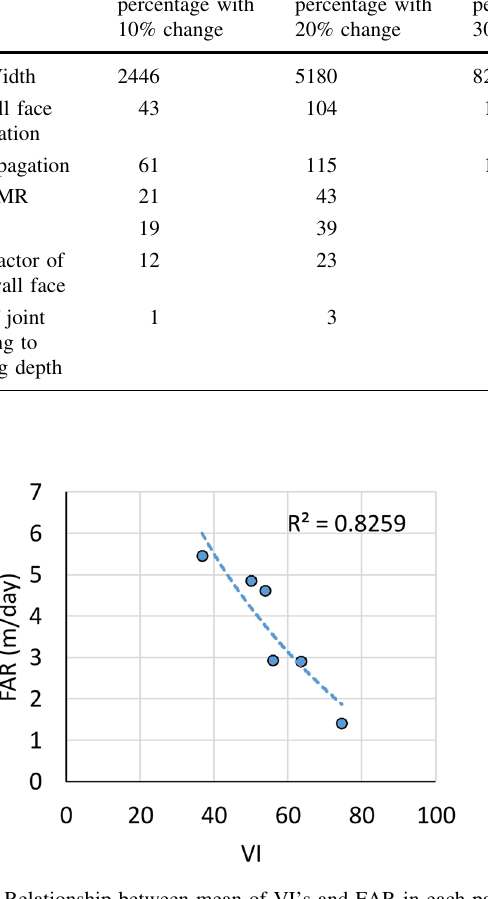
Fig. 15 Relationship between mean of VI’s and FAR in each panel, remove P